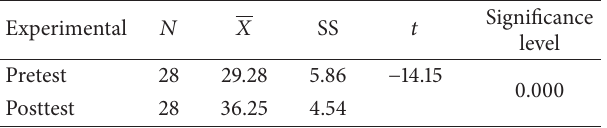
Table 3: Dependent groups 𝑡 -test results related to the pre- and posttest scores of the experimental group.